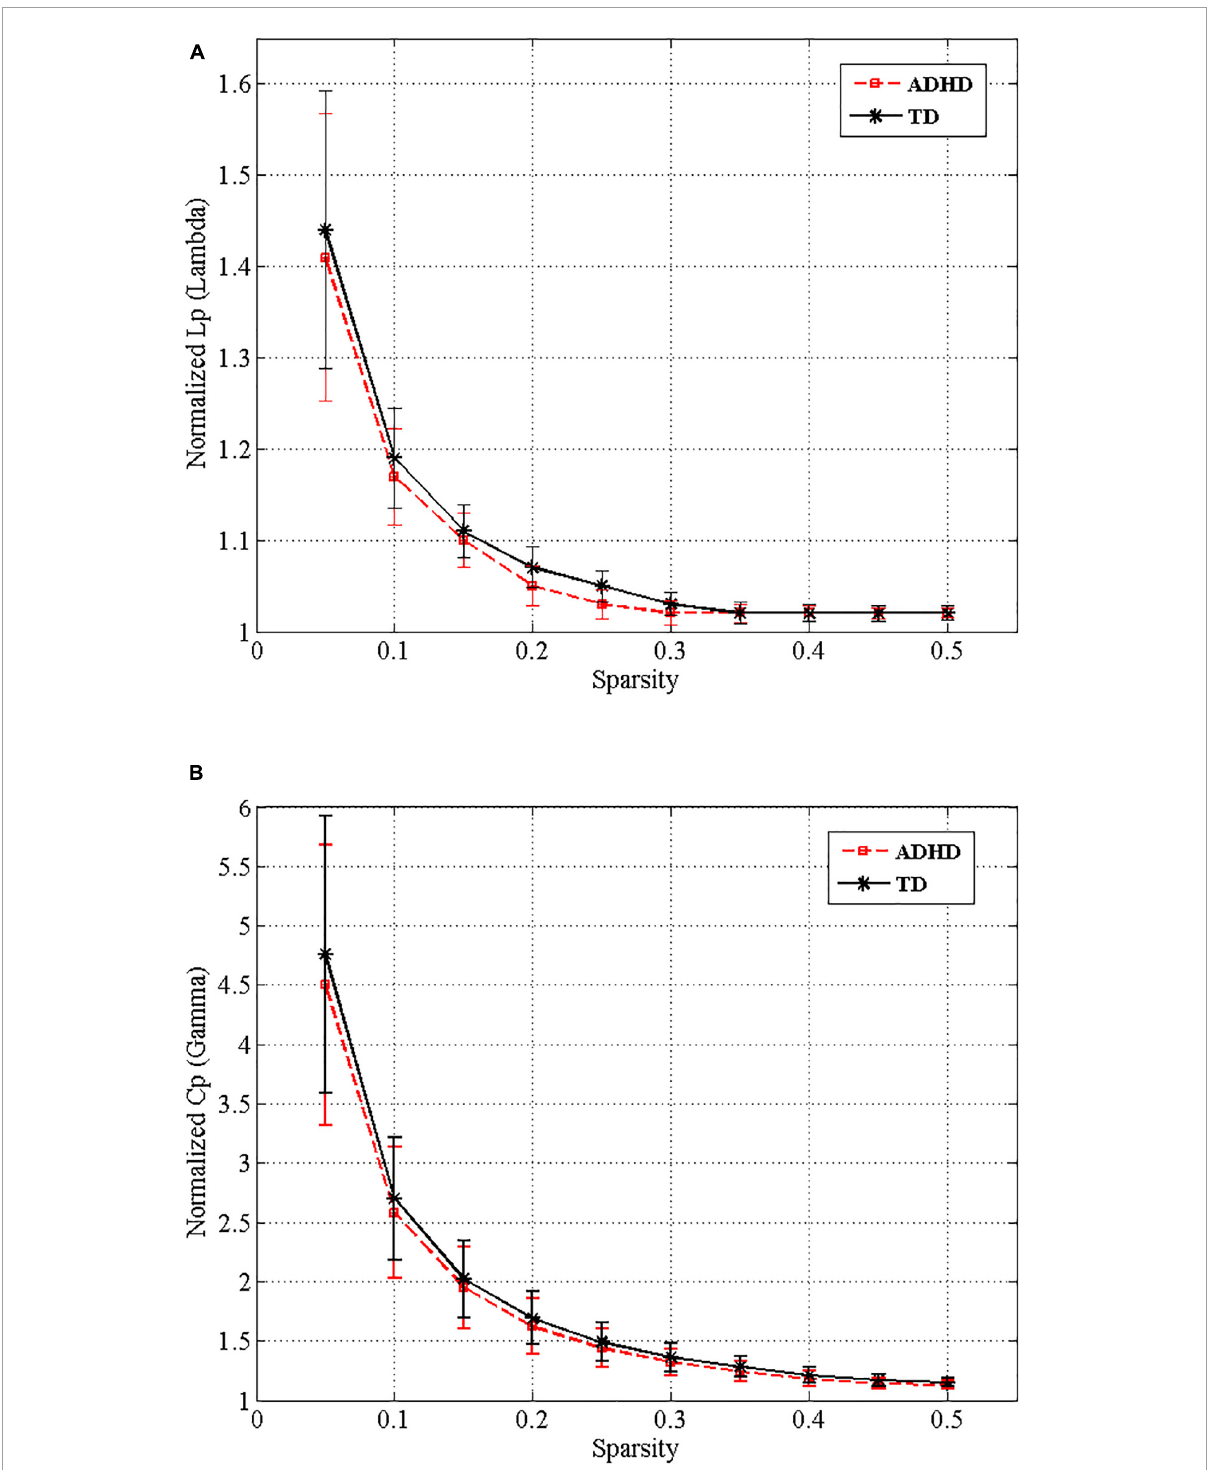
FIGURE3 Small-world properties of the functional whole-brain networks of drug-naive ADHD children and typical development (TD) controls over the different sparsity range. Normalized shortest path length (A) and normalized clustering coefficient (B) of ADHD (red dashed line) and TD (black line)